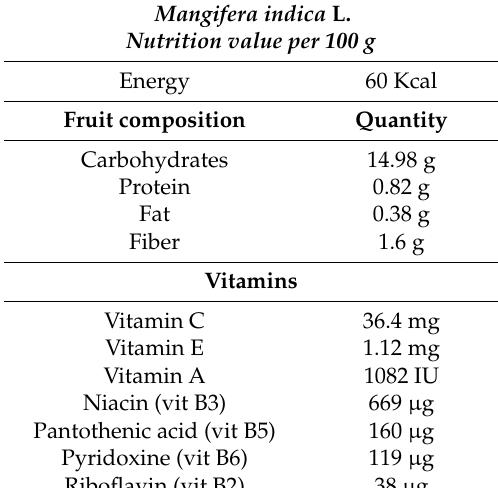
Table 1. Content of nutrients, vitamins, minerals, and carotenoids in Mangifera indica pulp. Mangifera indica